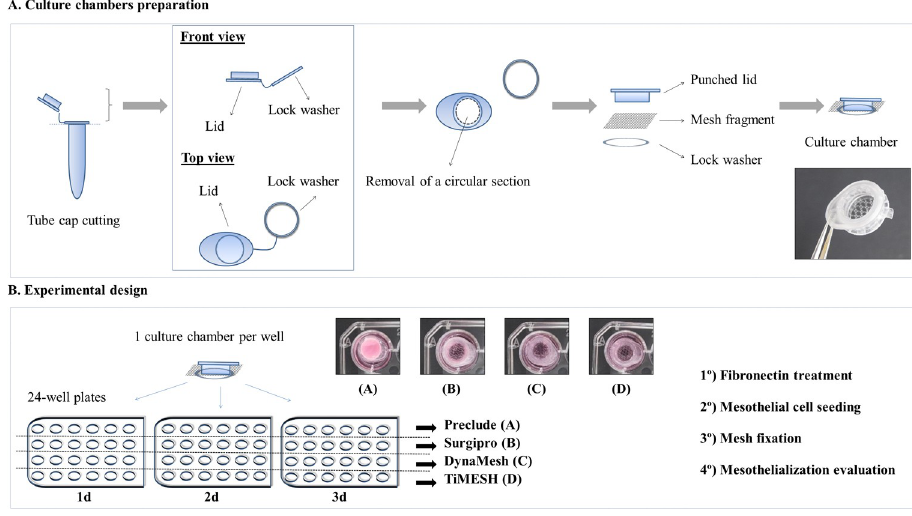
Fig 2. In vitro study. Illustration depicting the design of the culture chambers (A) and the experimental setup (B).